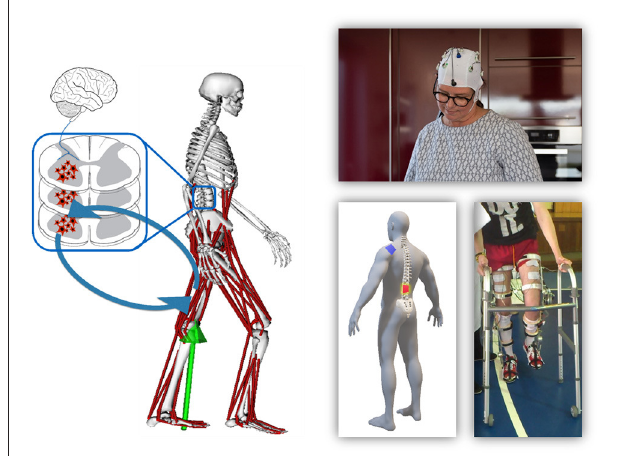
FIGURE 1 | Overview of the different organs involved in gait and their communication structure (left). The right side shows examples of prostheses that interface with these organs, specifically the brain (top), spinal cord (bottom left), or periphery (bottom right).